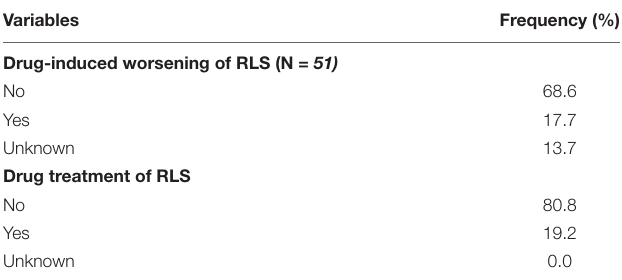
TABLE 4 | Restless legs syndrome (RLS) characteristics for variables measured at an ordinal or nominal